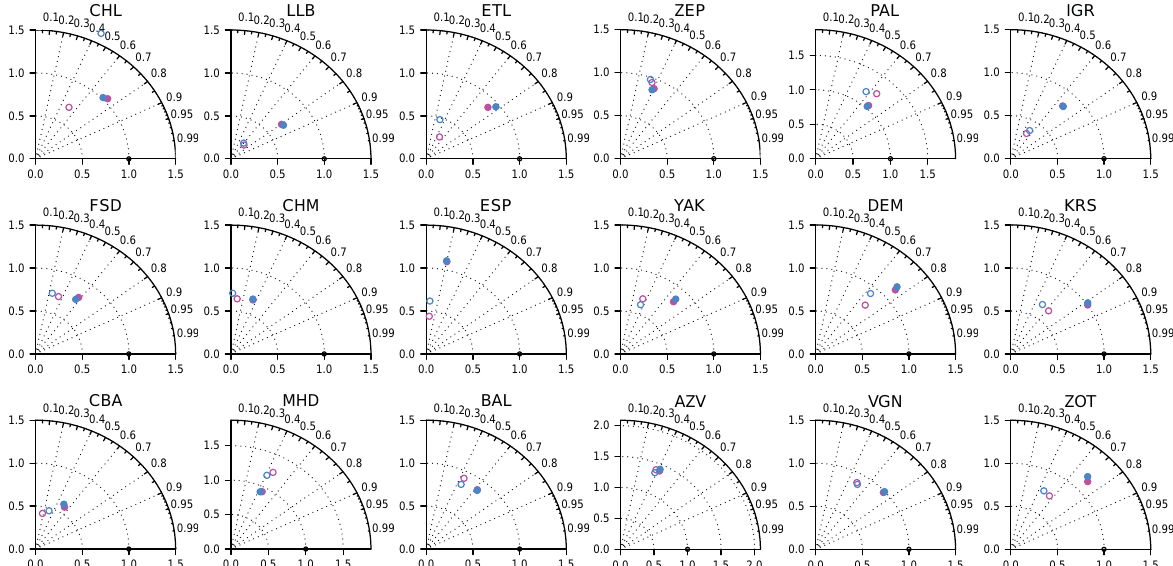
Figure 6. Taylor diagrams for the comparison of the prior (open circles) and posterior (solid circles) simulated concentrations with the observations for 2009 (the radius indicates the normalized standard deviation and the angle the correlation coefficient). The results for the two scenarios are shown (i.e. S1 in magenta and S2 in